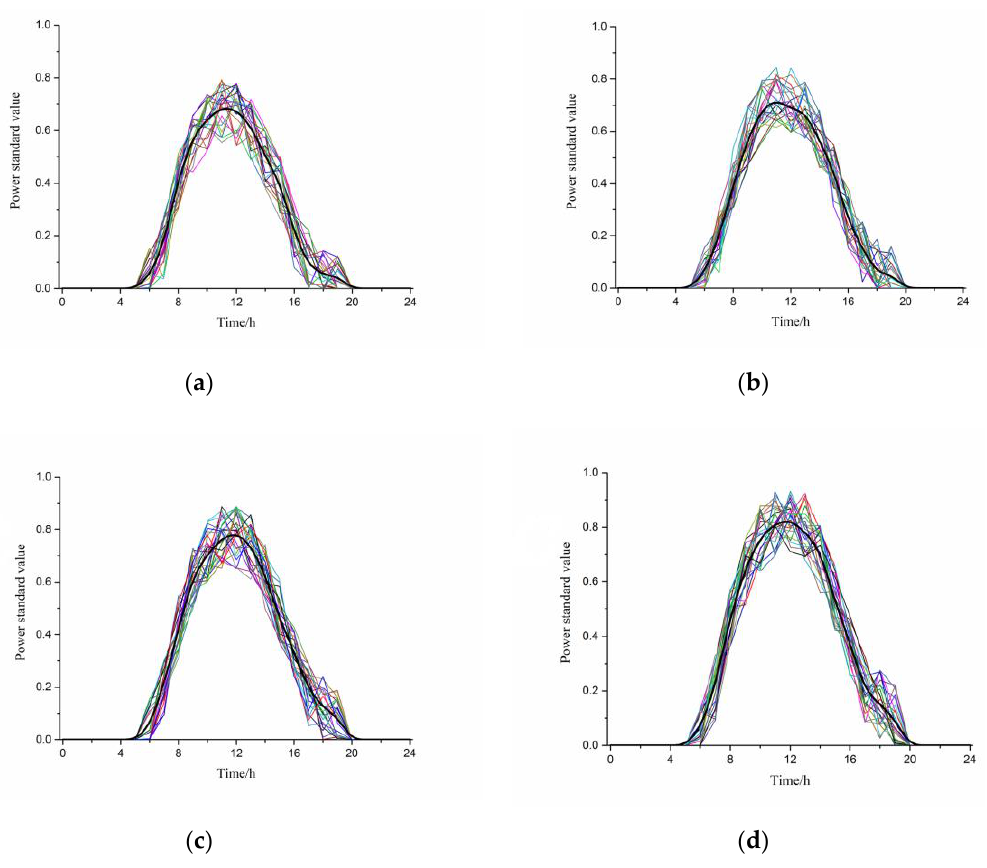
Figure 5. Photovoltaic generation in typical scenarios ( a ) Photovoltaic generation in scenario 1; ( b ) Photovoltaic generation in scenario 2; ( c ) Photovoltaic generation in scenario 3; ( d ) Photovoltaic generation in scenario 4.